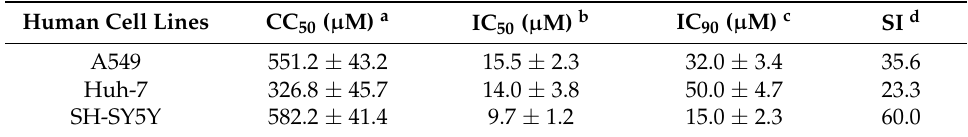
Figure 2. Q3G inhibits ZIKV growth across three human cell lines. Viral clone ZIKV MR766 MC was used to infect A549 ( a ) and Huh-7 ( b ) cells at MOI of 1 and SH-SY5Y ( c ) cells at MOI of 10. Increasing concentrations of Q3G or vehicle were added concurrently to virus input. Virus progeny production was determined at 48 h post-infection. Data represent the means ± SD of four independent experiments performed in triplicate. Table 1. Cytotoxicity and anti-ZIKV activity of